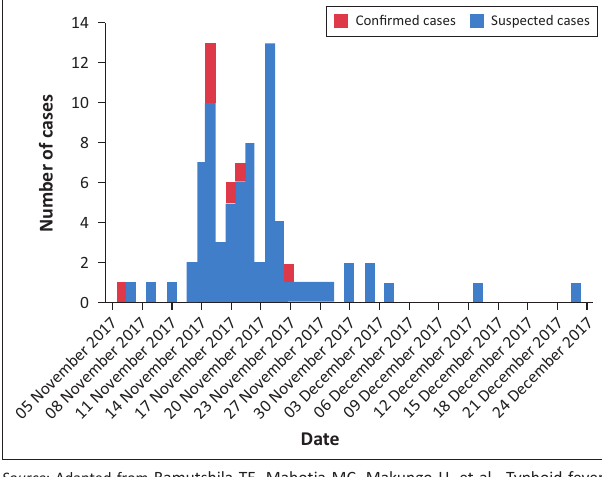
TABLE 1: Characteristics of typhoid fever cases, Sekhukhune District, Limpopo province, November – December 2017 ( N = 122).